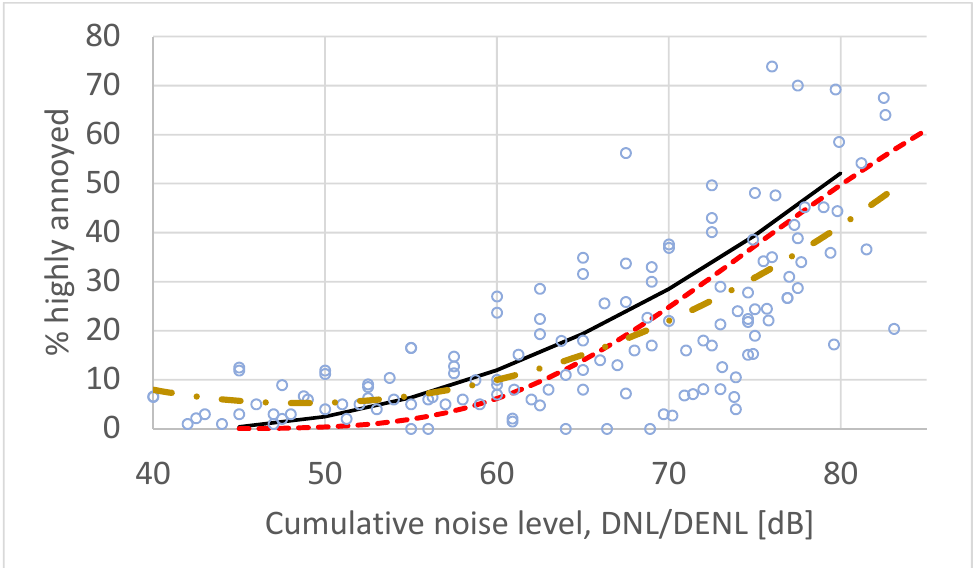
Figure 3. Set of paired data from 18 post-2000 surveys on road traffic noise. Solid line (black) is the ERF developed by Miedema and Vos. Standard second order polynomial regression yields the dashed ERF (yellow) while CTL analysis yields the dotted ERF (red).